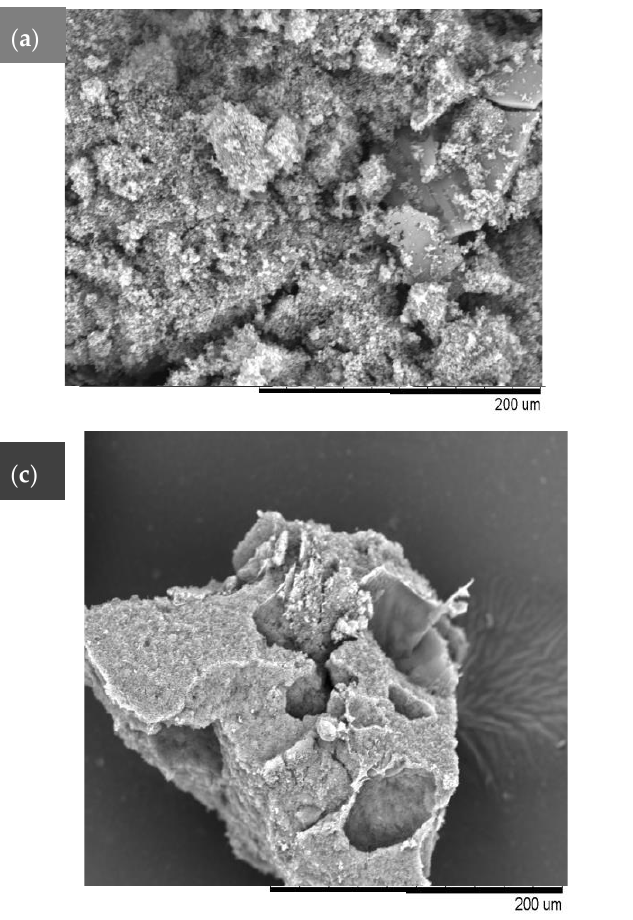
Figure 3. Scanning Electron Microscope Images for G1-D3-Asp ( a ), G2-D6-Asp ( b ), G3-D9-Asp ( c ), G4-D12-Asp ( d ).